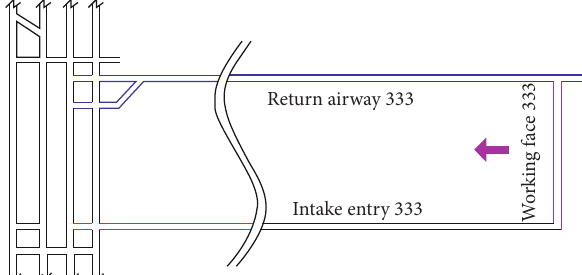
Figure 2: The schematic of the 333 return airway.